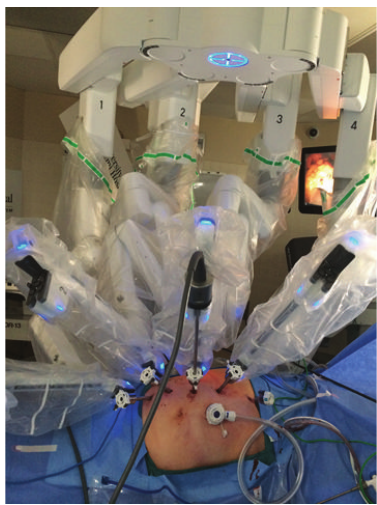
Figure 4: XI robot docked for right robotic partial